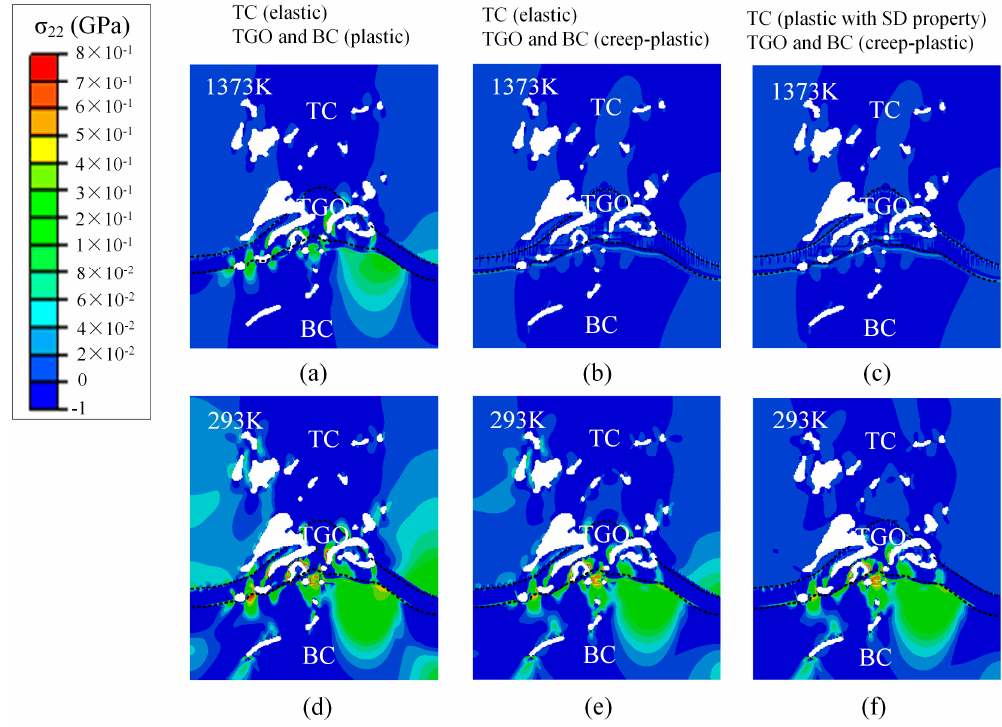
Figure 10. Contour plots of stress σ 22 in ( a – c ) TBC with ideal interface and ( d – f ) TBC with actual microstructures. And the different mechanical assumptions are considered: ( a , d ) TC is elastic, TGO and BC are elastic to plastic; ( b , e ) TC is elastic, TGO and BC are creep-plastic; ( c , f ) TC is plastic with SD property, TGO and BC are creep-plastic.